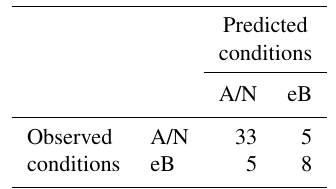
Table 3. Hit–miss matrix with only two categories: above-normal– near-normal (A/N), and extreme below-normal (eB)